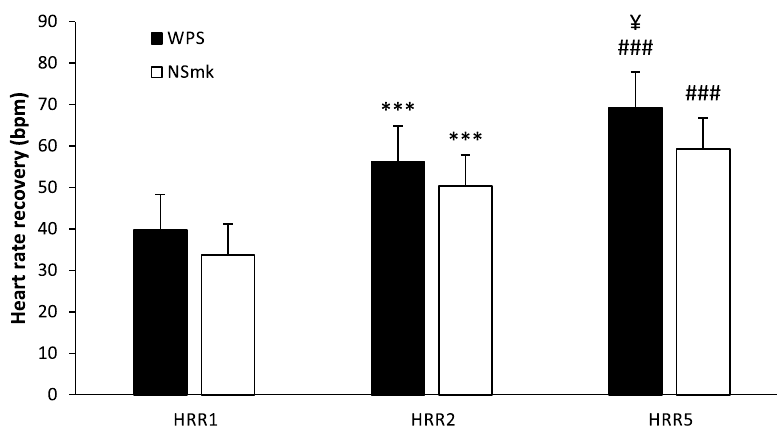
Figure 1 . Heart rate recovery after Wingate test for the WPS and NSmk groups. WPS = waterpipe smokers; NSmk = non-smokers; HRR1 = heart rate recovery at 1 min after exercise; HRR2 = heart rate recovery at 2 mins after exercise; HRR5 = heart rate recovery at 5 mins after exercise. *** p < .001 compared to HRR1 in the same group, ### p < .001 compared to HRR2 in the same group, ¥ p < .01 compared to NSmk for the same variable (i.e.,